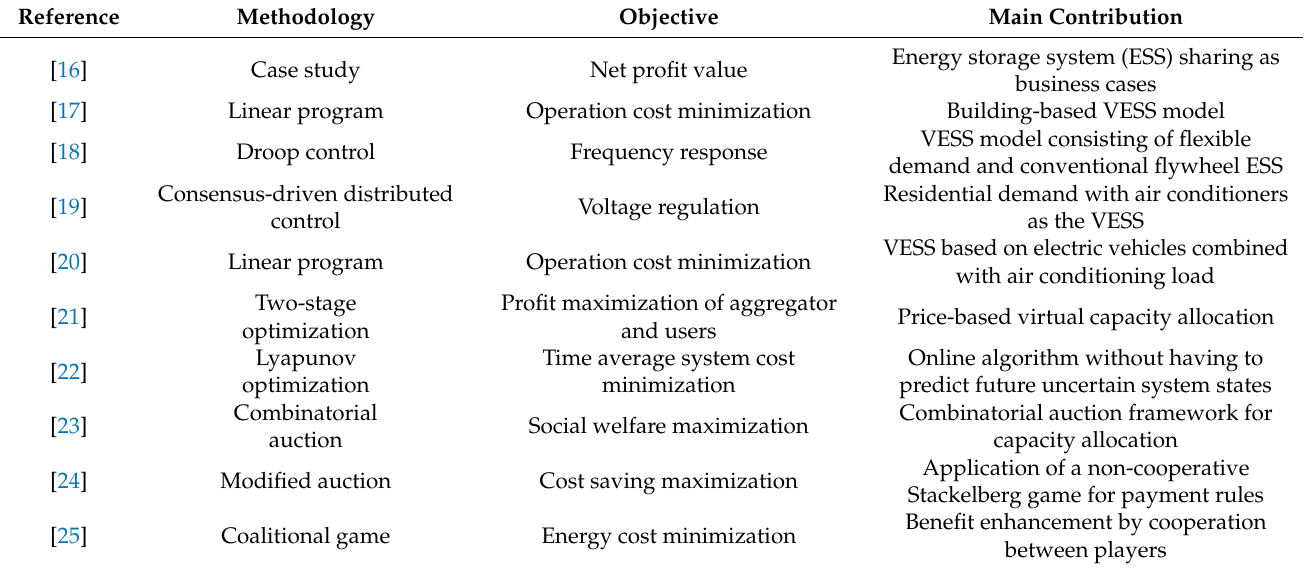
Table 1. Summary of virtual energy storage system (VESS)